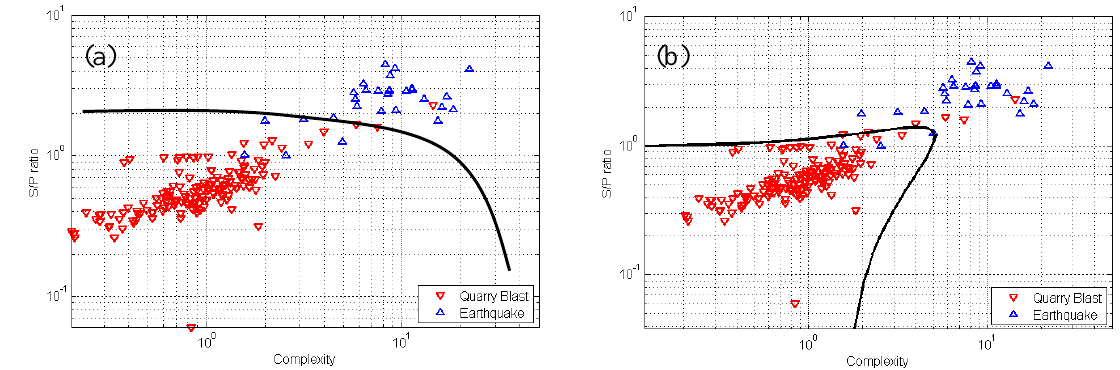
Fig. 7. Classification with discriminant functions: decision boundaries (black lines) shown represent the optimal trade-off between performance on the dataset and simplicity of classifier, thereby giving the highest accuracy. The two algorithms (a) linear discriminant functions (b) quadratic discriminant functions are presented. Blue and red colors indicate earthquakes and quarry blasts. The overall accuracies are 96.1% and 96.6% respectively.